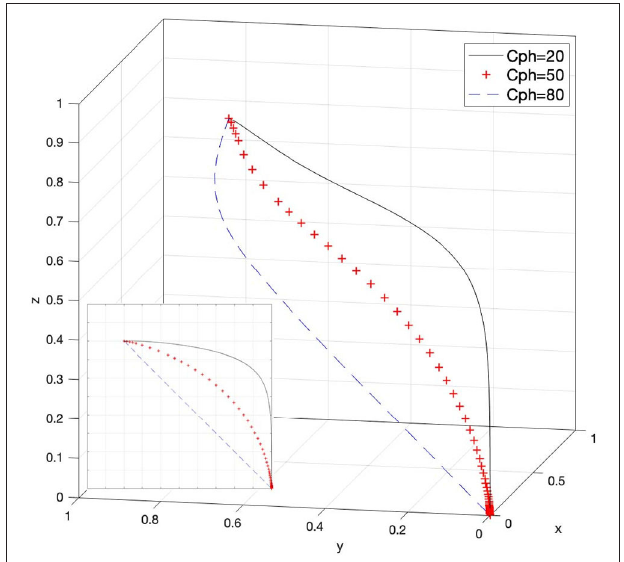
FIGURE 10 | Effect of the cost of strict supervision by the